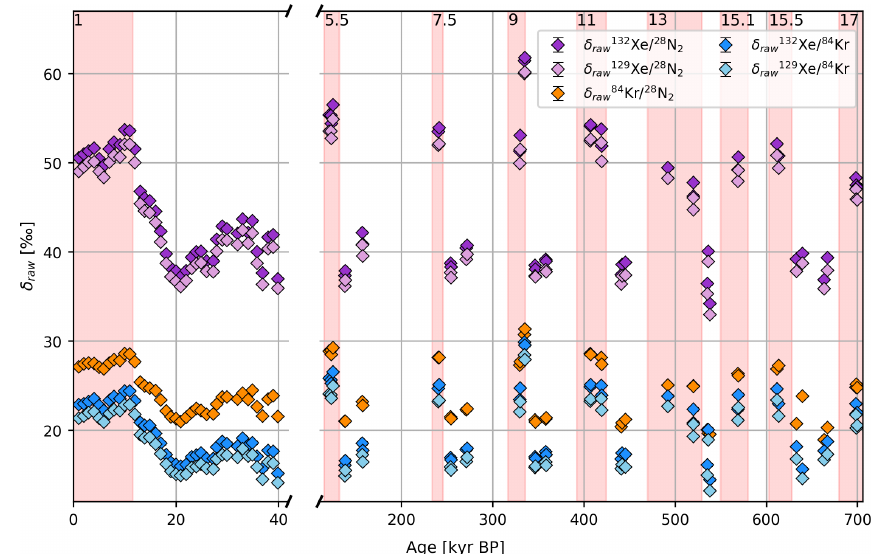
Figure 1. Measured delta values of the EDC elemental ratios from 700kyrBP to the present. The analytical uncertainties of the elemental ratios are too small (on the order of 0.1‰; see text) to be displayed here. The red shaded intervals indicate interglacials as identified by Masson-Delmotte et al.